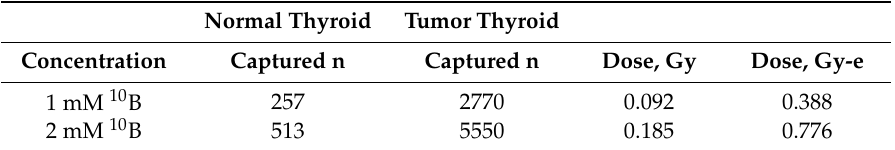
Table 2. Neutron HISPANoS (Hispalis Neutron Source) 1-h irradiation parameters of a rat thyroid